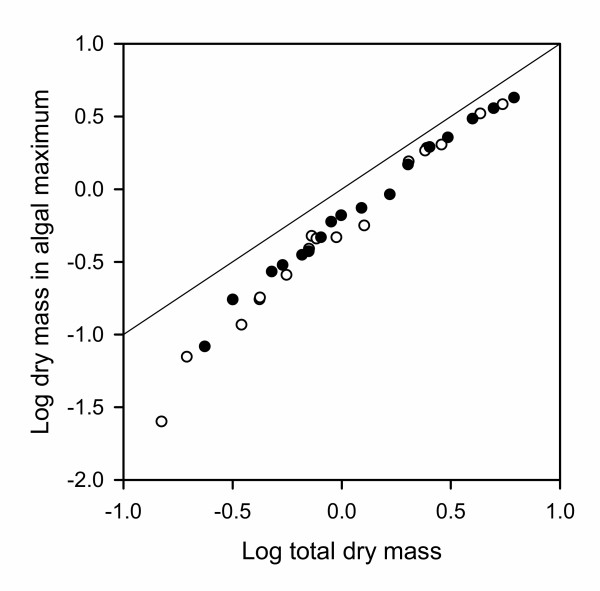
Relation between the total mass of Daphnia per tower and in the algal maximum. Symbols indicate the two mesocosms. Line of equality indicated.